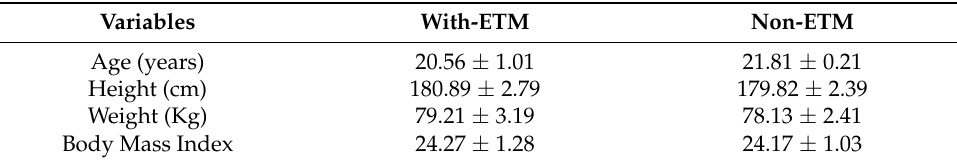
Table 1. Physical characteristics of both groups (experimental group: n = 22; control group: n = 22) presented as mean ± SD.